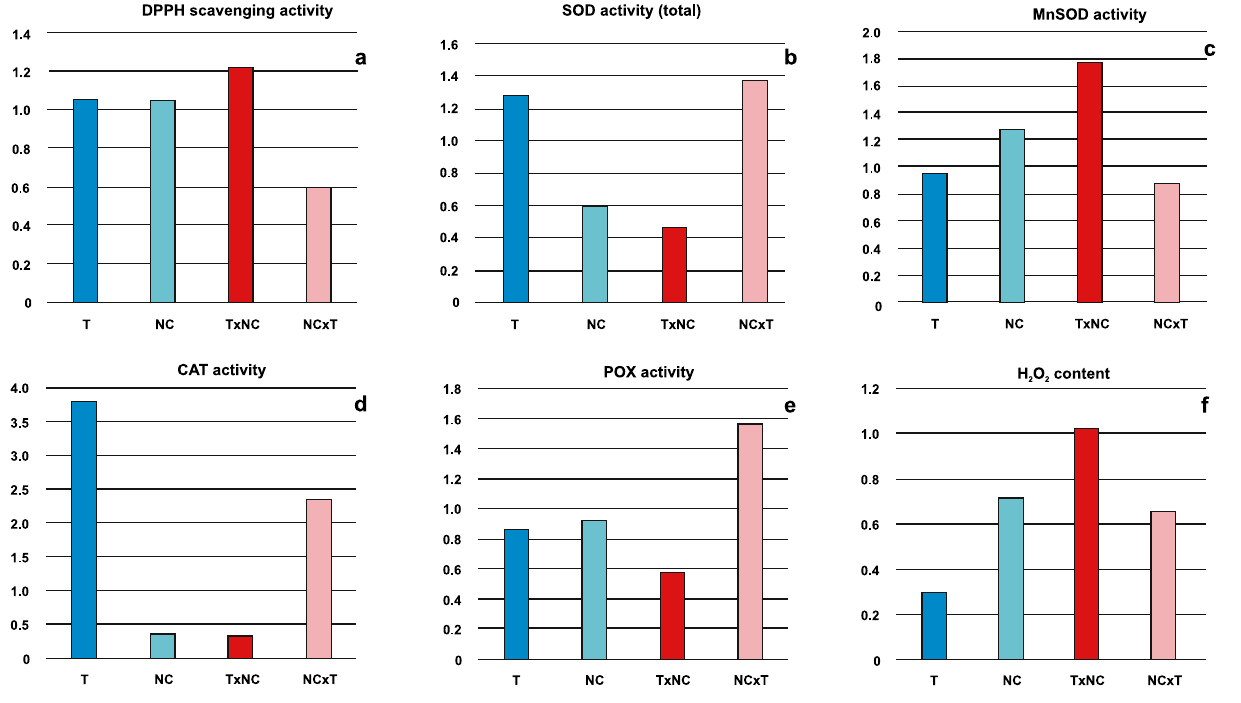
Figure 3. M/F ratios calculated for selected parameters of antioxidant system in four R. hastatulus forms. ( a ) DPPH free radical scavenging activity; ( b ) total SOD activity; ( c ) MnSOD activity; ( d ) CAT activity; ( e ) POX activity; ( f ) endogenous H 2 O 2 content.